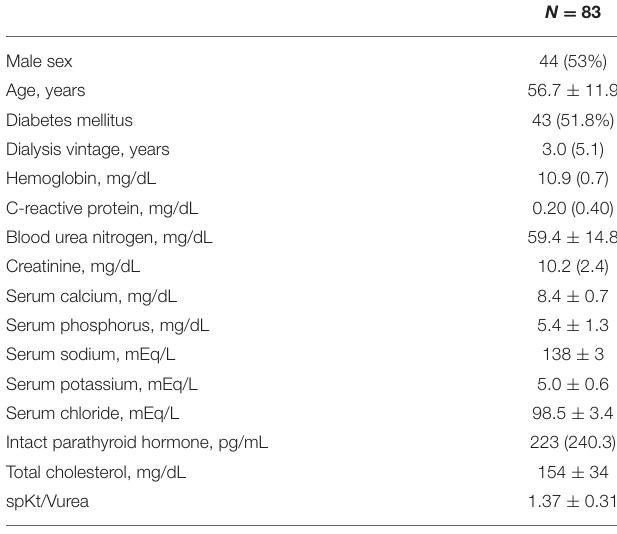
TABLE 1 | Participants’ clinical